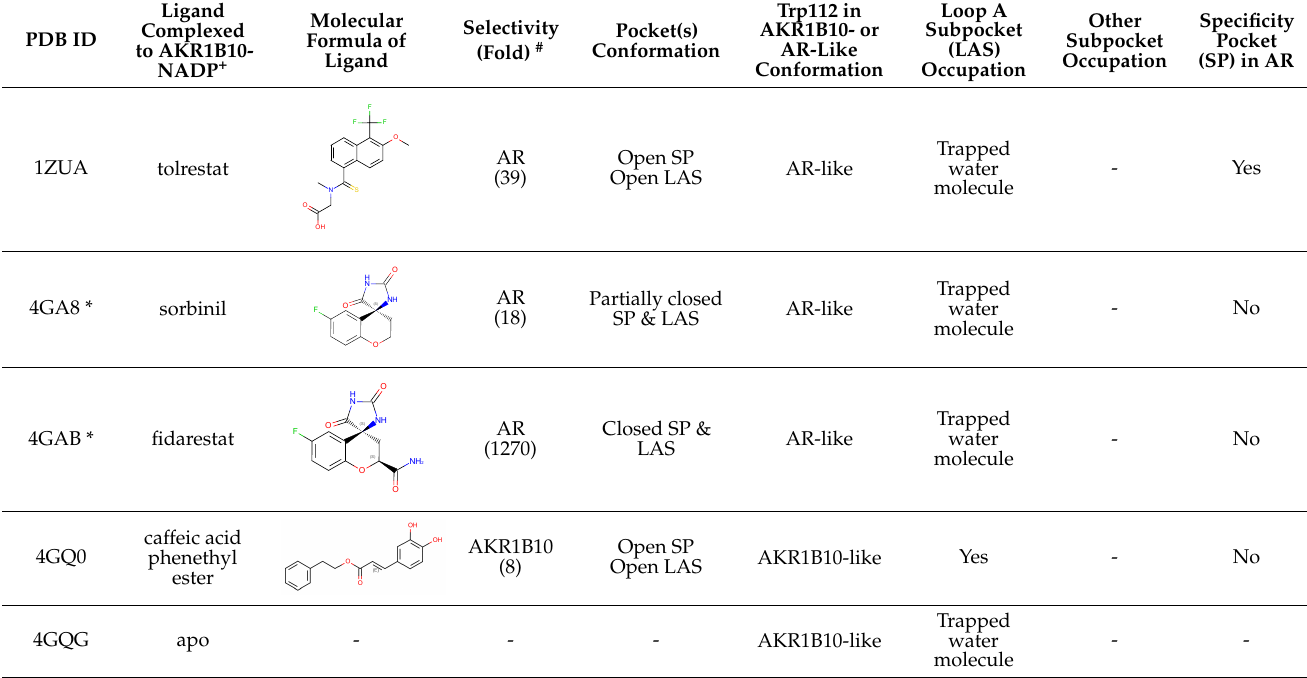
Table A1. Main features of AKR1B10 crystallographic